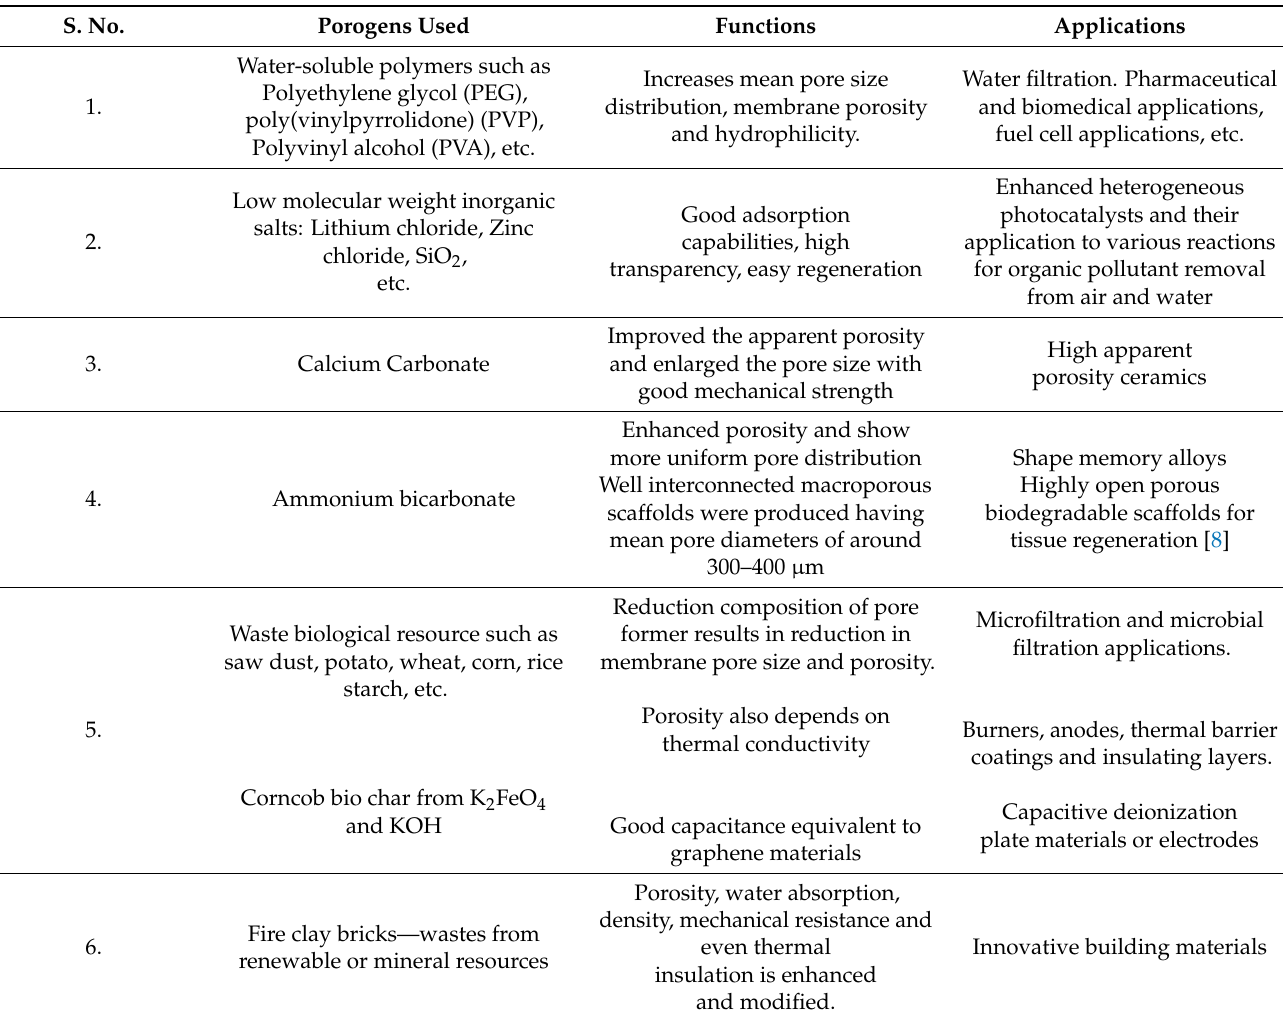
Table 1. Various types of porogens with their functions and